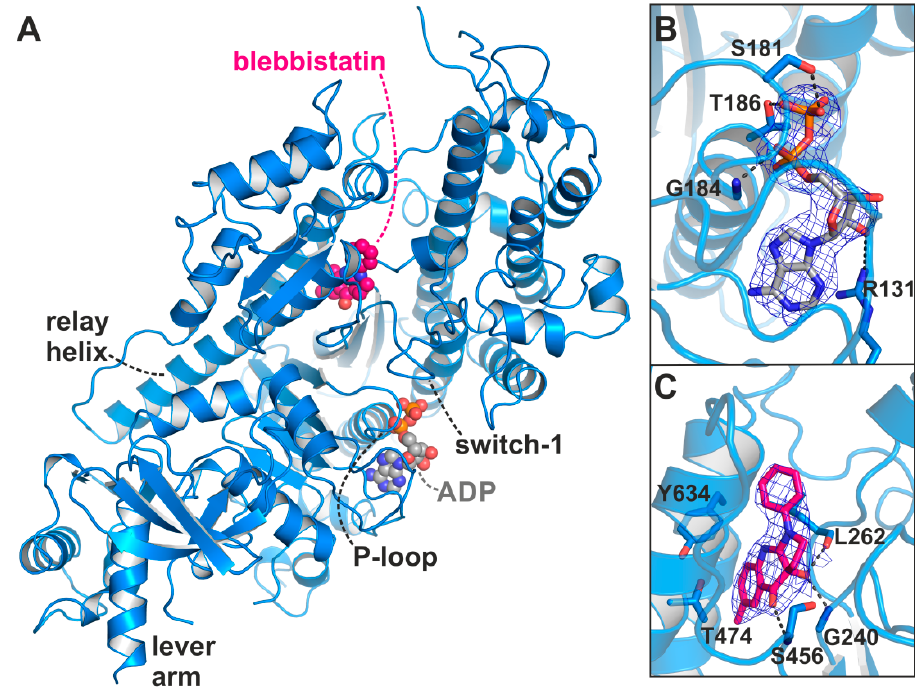
Figure 2. X-ray crystal structure of the Dd myosin-II motor domain in complex with ADP and blebbistatin. ( A ) Overview of the crystal structure in the blebbistatin-bound ADP-release conformation. The P-loop together with the bound ADP (grey) is shifted towards the surface. Blebbistatin (magenta) is buried in the known allosteric binding pocket at the apex of the large actin-binding cleft. ( B ) The 2F o -F c density map of ADP in its new binding position. The map was contoured at 1.0 σ . Note that the β -phosphate has rotated away from the P-loop. ( C ) 2F o -F c density map of blebbistatin at the apex of the actin-binding cleft and near the relay helix. The map was contoured at 1.0 σ . Table 1. Data collection and refinement statistics.